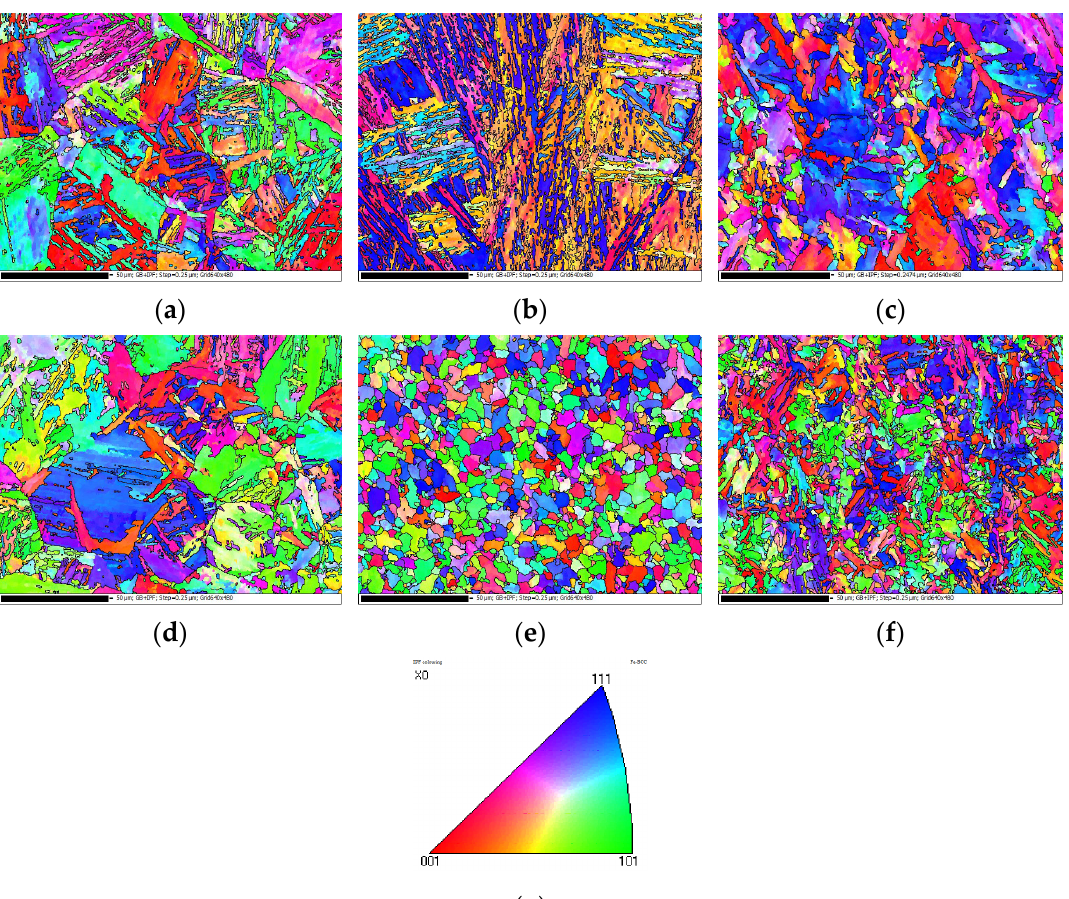
Figure 11. IPF maps of the welding thermal simulation samples: ( a ) CGHAZ of 0 V; ( b ) GRHAZ of 0 V; ( c ) ICHAZ of 0 V; ( d ) CGHAZ of 10 V; ( e ) GRHAZ of 10 V; and ( f ) ICHAZ of 10 V; ( g ) crystallographic orientation